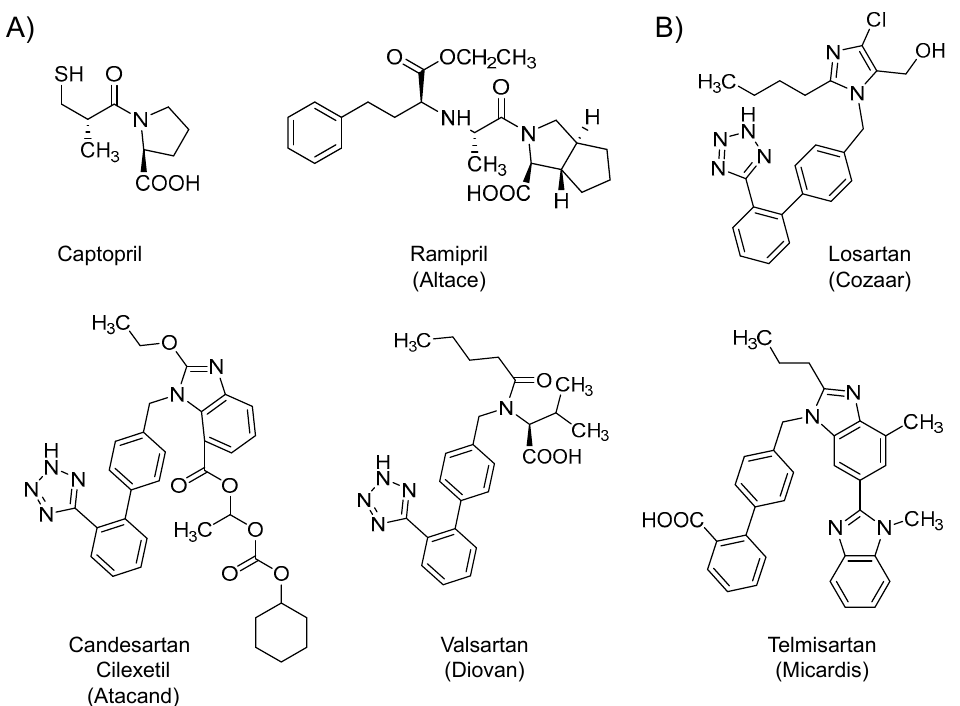
Figure 3. The chemical structures of RAAS modifiers. ( A ) The chemical structures of ACEIs and ( B ) The chemical structures of ARBs that are being tested with relevance to COVID-19.